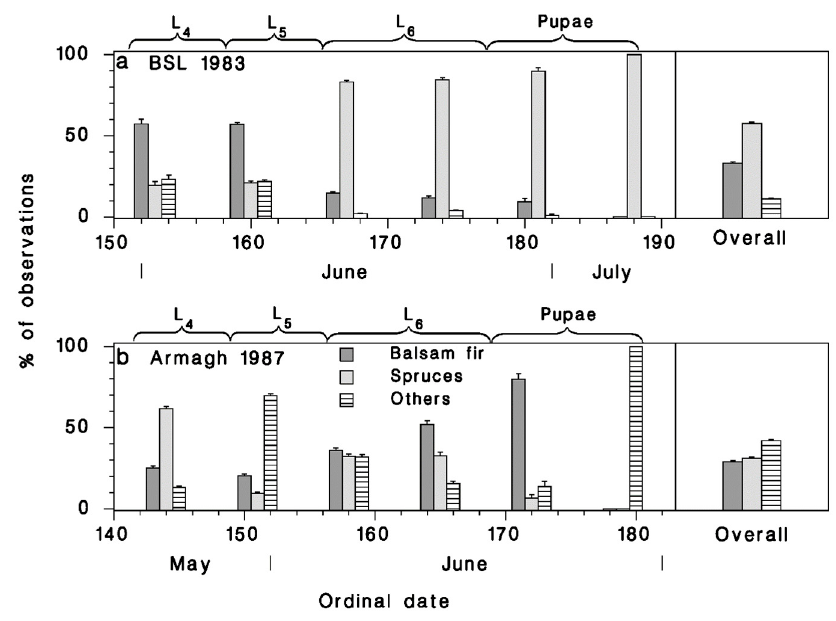
Figure 7. Relative frequency of observations recorded on various tree species, at ( a ) BSL in 1983 and ( b ) Armagh in 1987 over time in the summer and overall. Vertical lines: standard error (cid:16)(cid:112) (cid:17) p ( 1 − p ) / n . Seasonal development of budworm illustrated above each temporal frame.